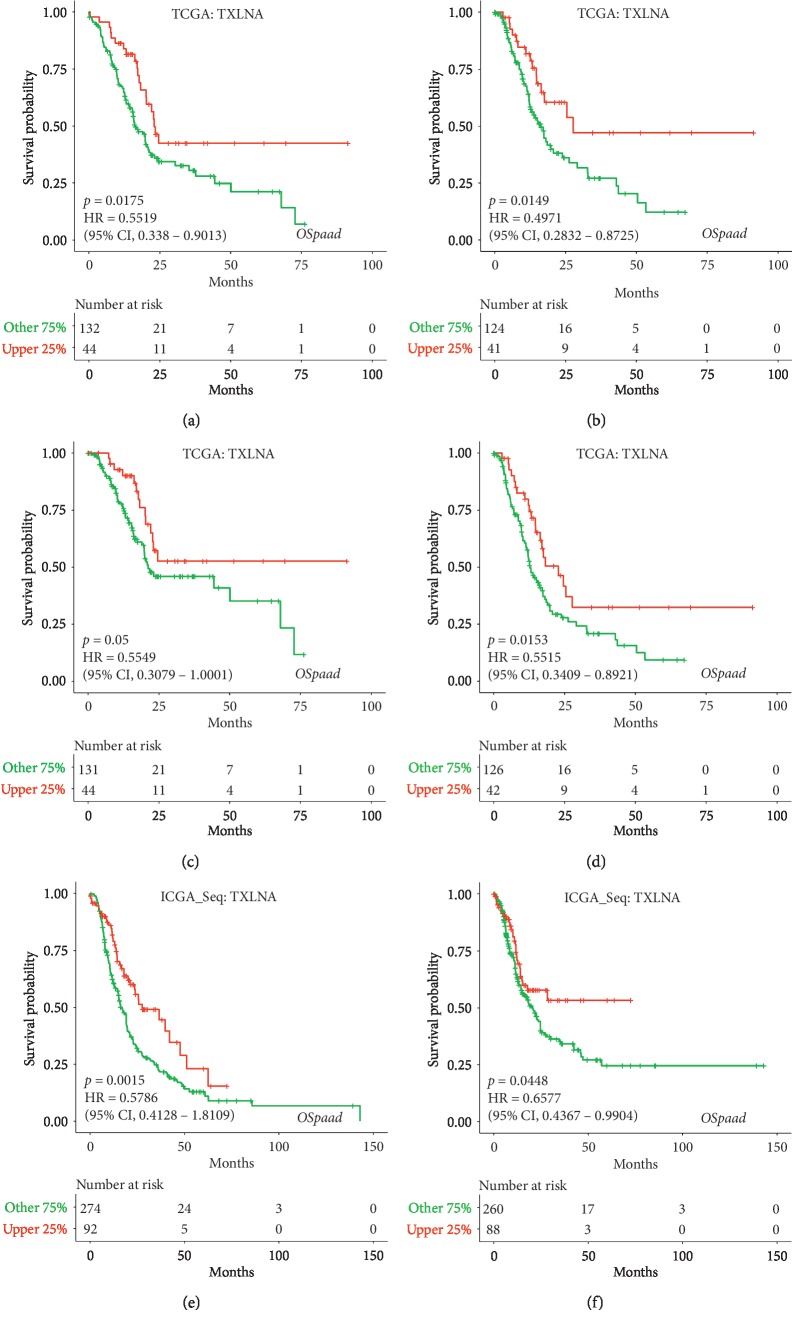
Kaplan-Meier curves of overall survival (OS) (a), disease-free interval (DFI) (b), disease specific survival (DSS) (c), and progression-free interval (PFI) (d) from TCGA data in PAAD. Kaplan-Meier curves of overall survival (OS) (e) and disease-free interval (DFI) (f) from ICGA data in PAAD.